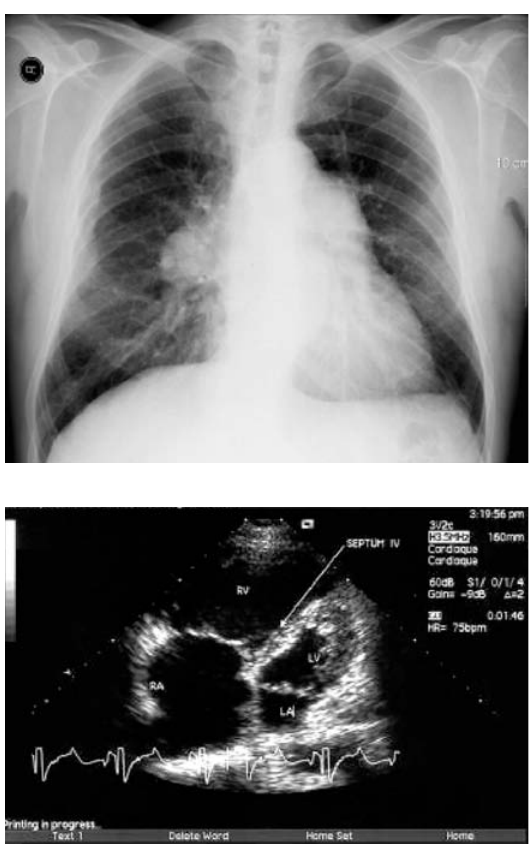
Qualitative echocar- diographic approach: four chamber transthoracic Doppler echocardiography view in a patient with severe idiopathic pul- monary hyperten- sion, showing an en- larged right ventricle and right atrium, the compression of the left ventricle and the flattening of the in- terventricular septum during diastole (cour- tesy of: G. Fiori, MD, Regional Hospital,